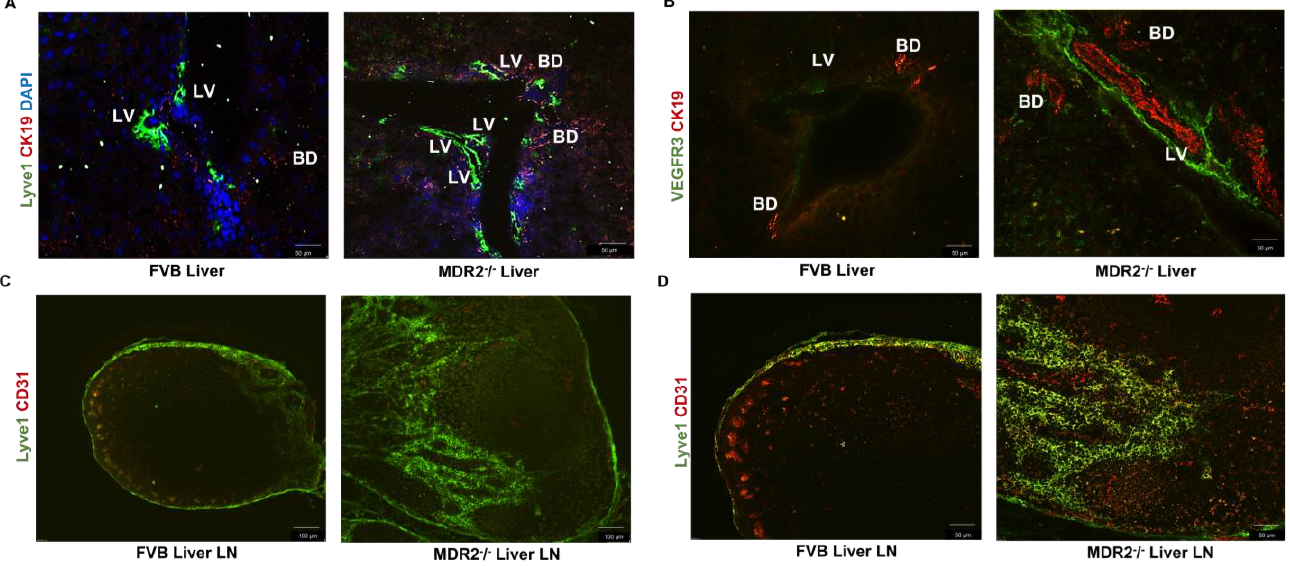
Figure 1. Mouse model of primary sclerosing cholangitis (Mdr2 −/− ) shows enhanced level of lymphangiogenesis in liver and liver lymph nodes (liver LN). Immunofluorescence images of liver tissue sections from Mdr2 −/− mice ( A , B ) taken at 20x magnification show high level of LYVE-1 expression ( A ) (green) and VEGFR3 (green) expression ( B ), indicating upregulated hepatic lymphatic infiltration. The cholangiocytes were stained with CK 19 (red). ( C , D ) Liver lymph node (liver LNs) images taken at 10x and 20x magnification from Mdr2 −/− mice showed increased LYVE-1(green) and CD31 (red) expression, indicating high nodal lymphatic infiltration. Scale bar is 50 μm and 100 μm.